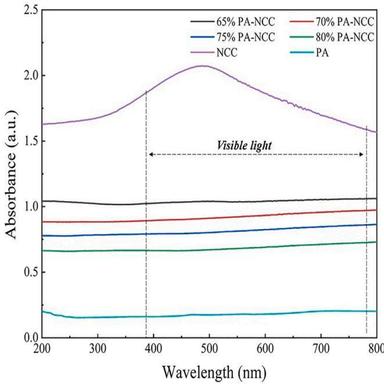
UV–Vis absorption spectra of the different samples.